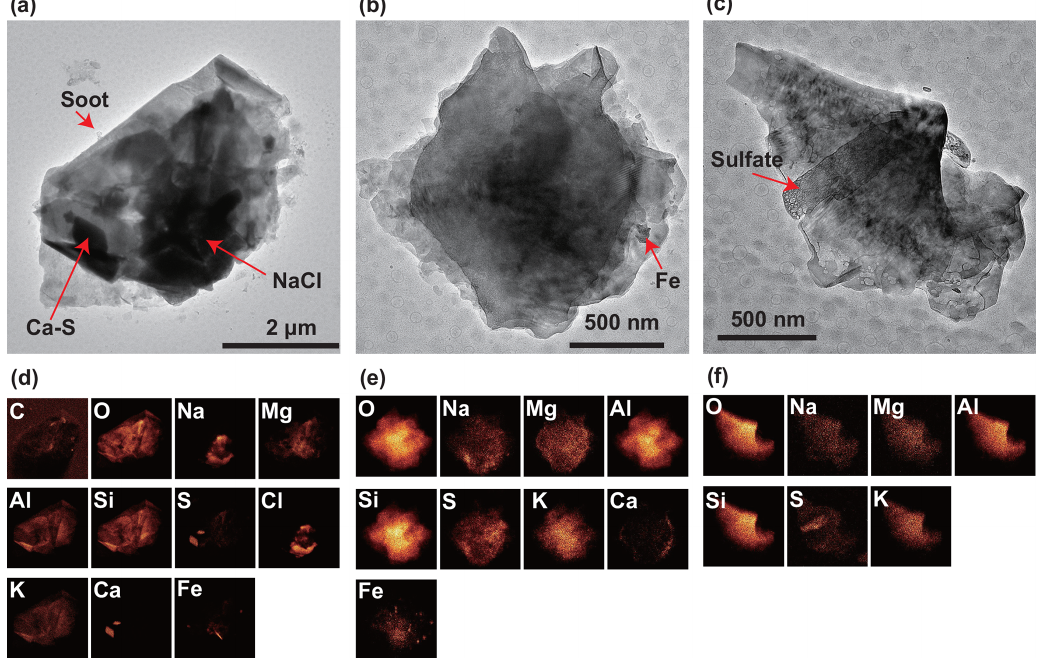
Figure 10. TEM and elemental mapping images of the mineral-dust particles. Top (a–c) : TEM images of the mineral-dust particles. Bottom (d–f) : elemental mapping images of the TEM areas for the detected elements. All particles were found in the samples collected from 10:00– 10:19UTC on 30 March 2018. Soot, NaCl, and Ca-S particles are attached to these mineral-dust particles in panel (a) . Fe occurs as grains in panel (b) . Sulfate is attached to the mineral-dust particle in panel (c)